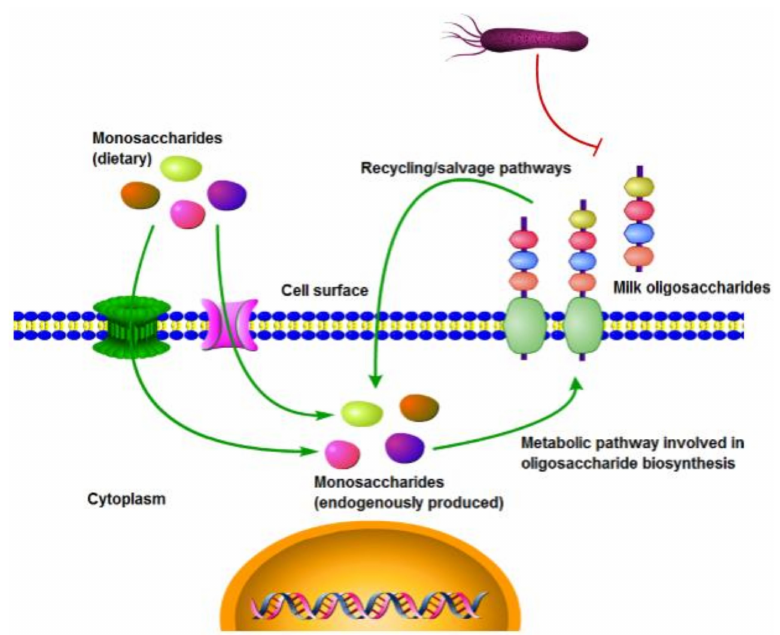
Figure 2. Hypothetical model indicating that dietary monosaccharides (DMs) might be taken up by the intestinal cell and used for the synthesis of cell surface glycoconjugates [145] with modifications). These glycoconjugates and milk oligosaccharides (MOs) might inhibit the adhesion to the cell of bacterial